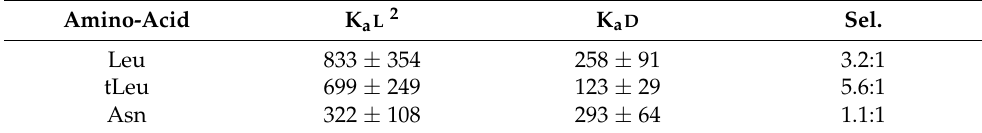
Table 2. Binding affinities of complexes between 1 and methyl ester HCl salts of Leu, t-Leu and Asn 1 .